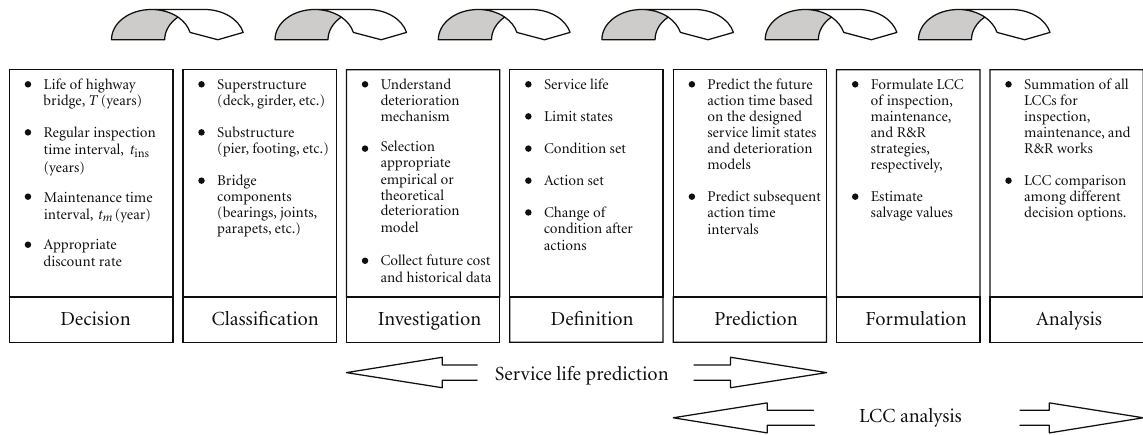
Figure 8: Suggested LCM flows for inspection, maintenance, and replacement and rehabilitation